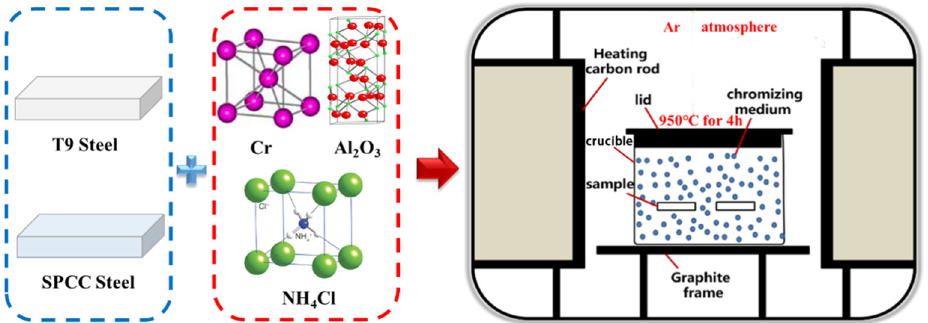
Figure 1. Schematic diagram of the chromizing device.